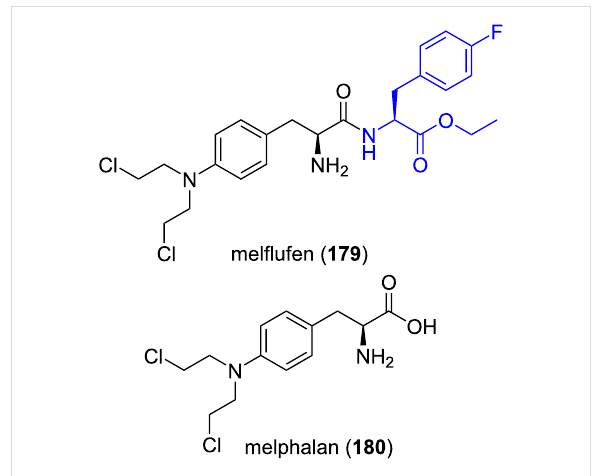
Figure 3: Structures of melfufen ( 179 ) and melphalan ( 180 ) anti- cancer